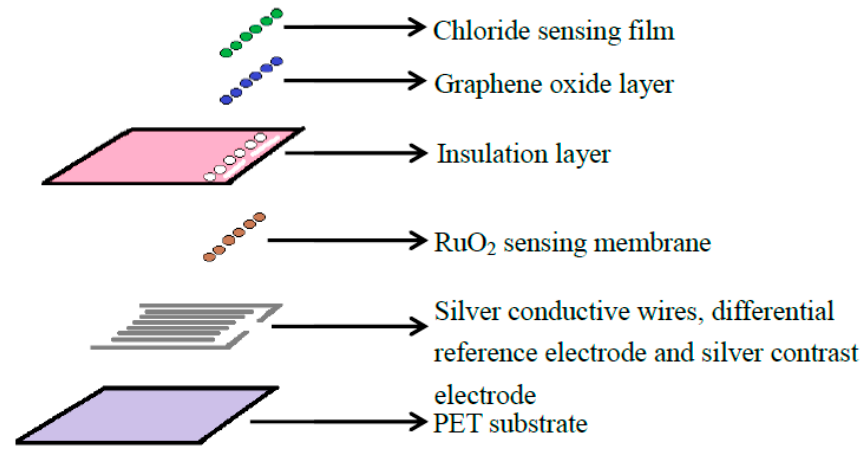
Figure 2. The fabrication process of the arrayed flexible RuO 2 /GO chloride ion sensor [14,29,30].